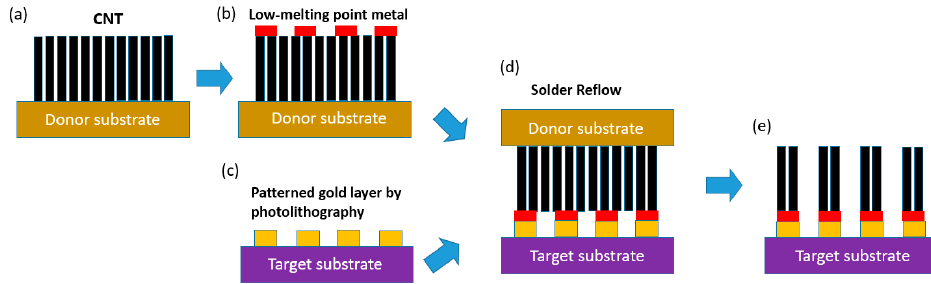
Figure 2. Schematic of CNT transfer method: ( a ) vertically-aligned CNT growth; ( b ) evaporation of low-melting point metal such as solder through hard mask onto CNT array; ( c ) preparation of target substrate; ( d ) solder reflow process to bond the CNT array and target substrate; ( e ) separation of CNT array from donor substrate.